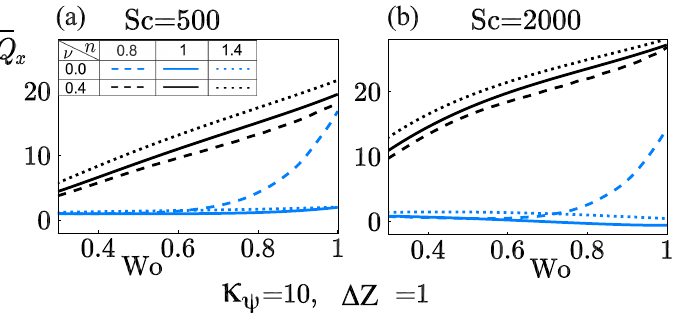
Figure 9. Rate of mass transport ¯ Q x as a function of Wo at different flow behavior indices n and the steric factor ν . ( a ) Sc = 500 and ( b ) Sc = 2000.